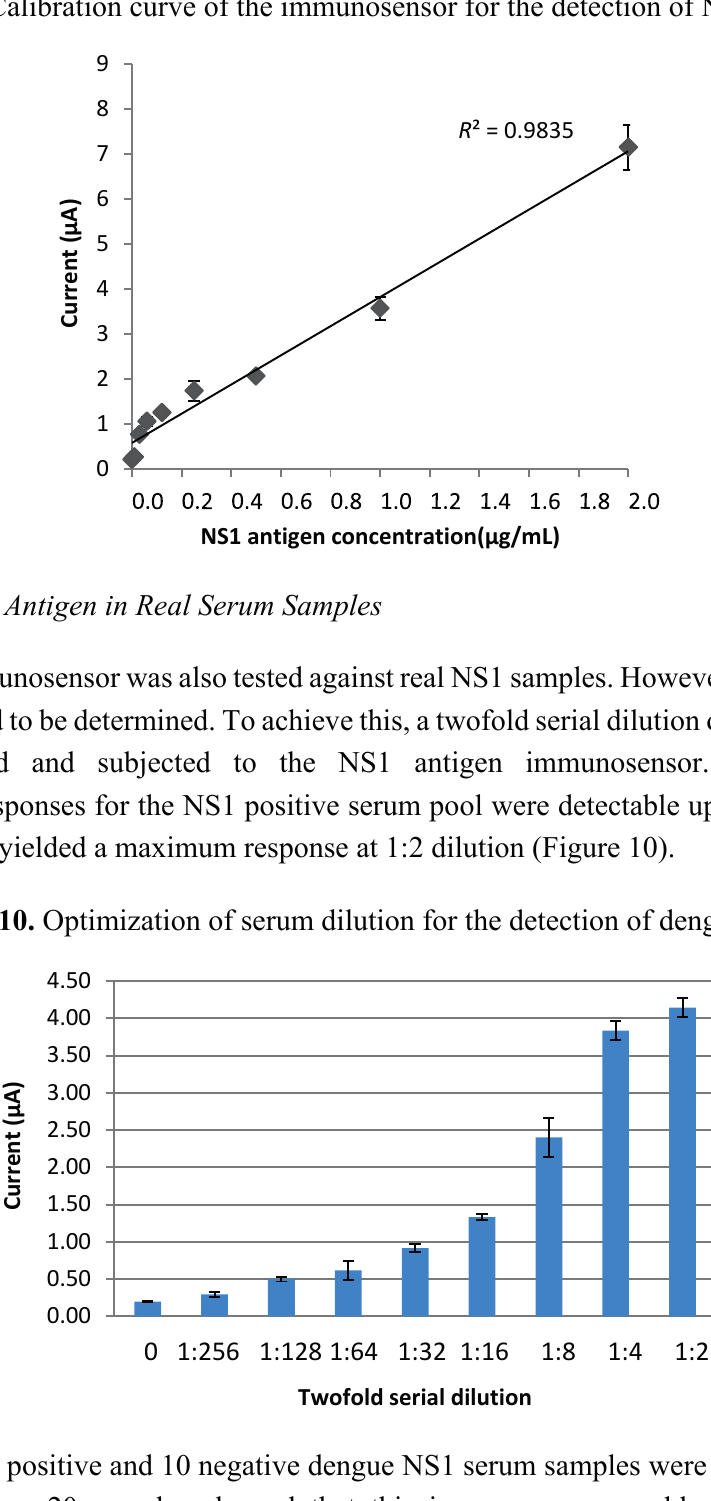
Figure 9. Calibration curve of the immunosensor for the detection of NS1 protein.